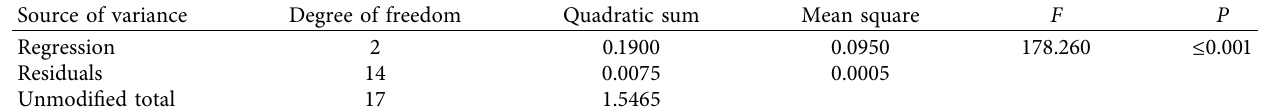
Table 3: Model variance analysis results of the relationship between PPDV and tunnel spacing.